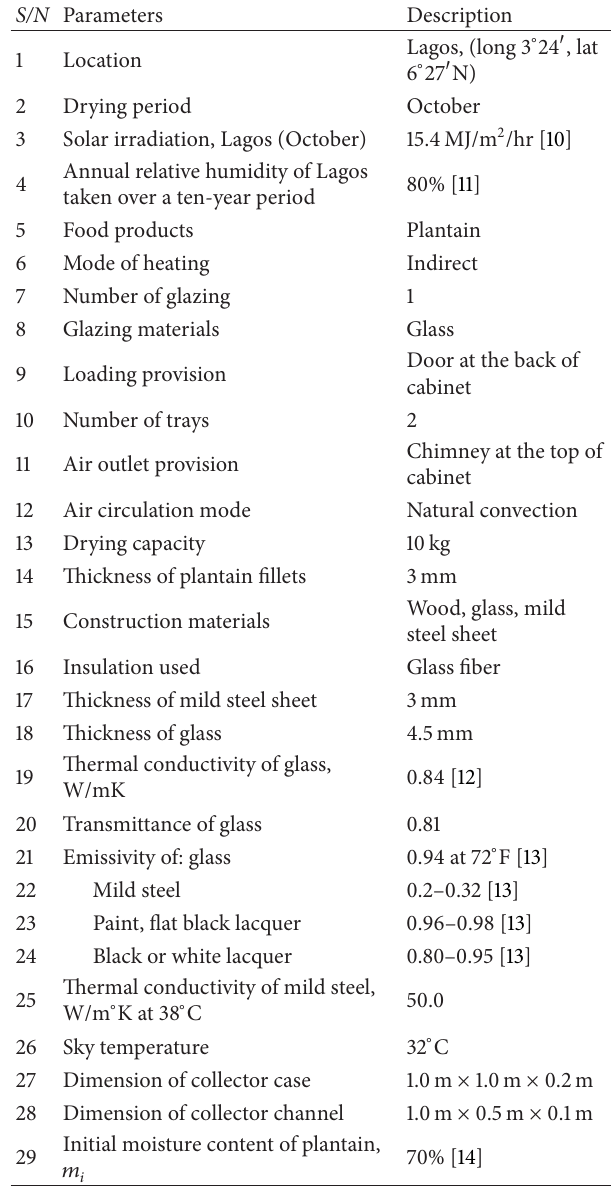
Table 1: Design considerations and